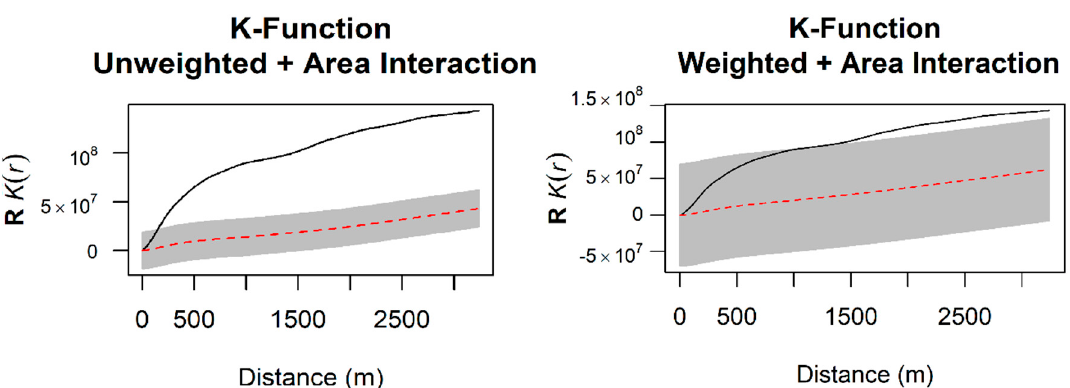
Figure 9. Residual K-function test of the best-fitting unweighted PPM with an area interaction parameter and the best-fitting weighted PPM with an area interaction parameter. Both models performed better with area interaction than without and the weighted model yields the best results.